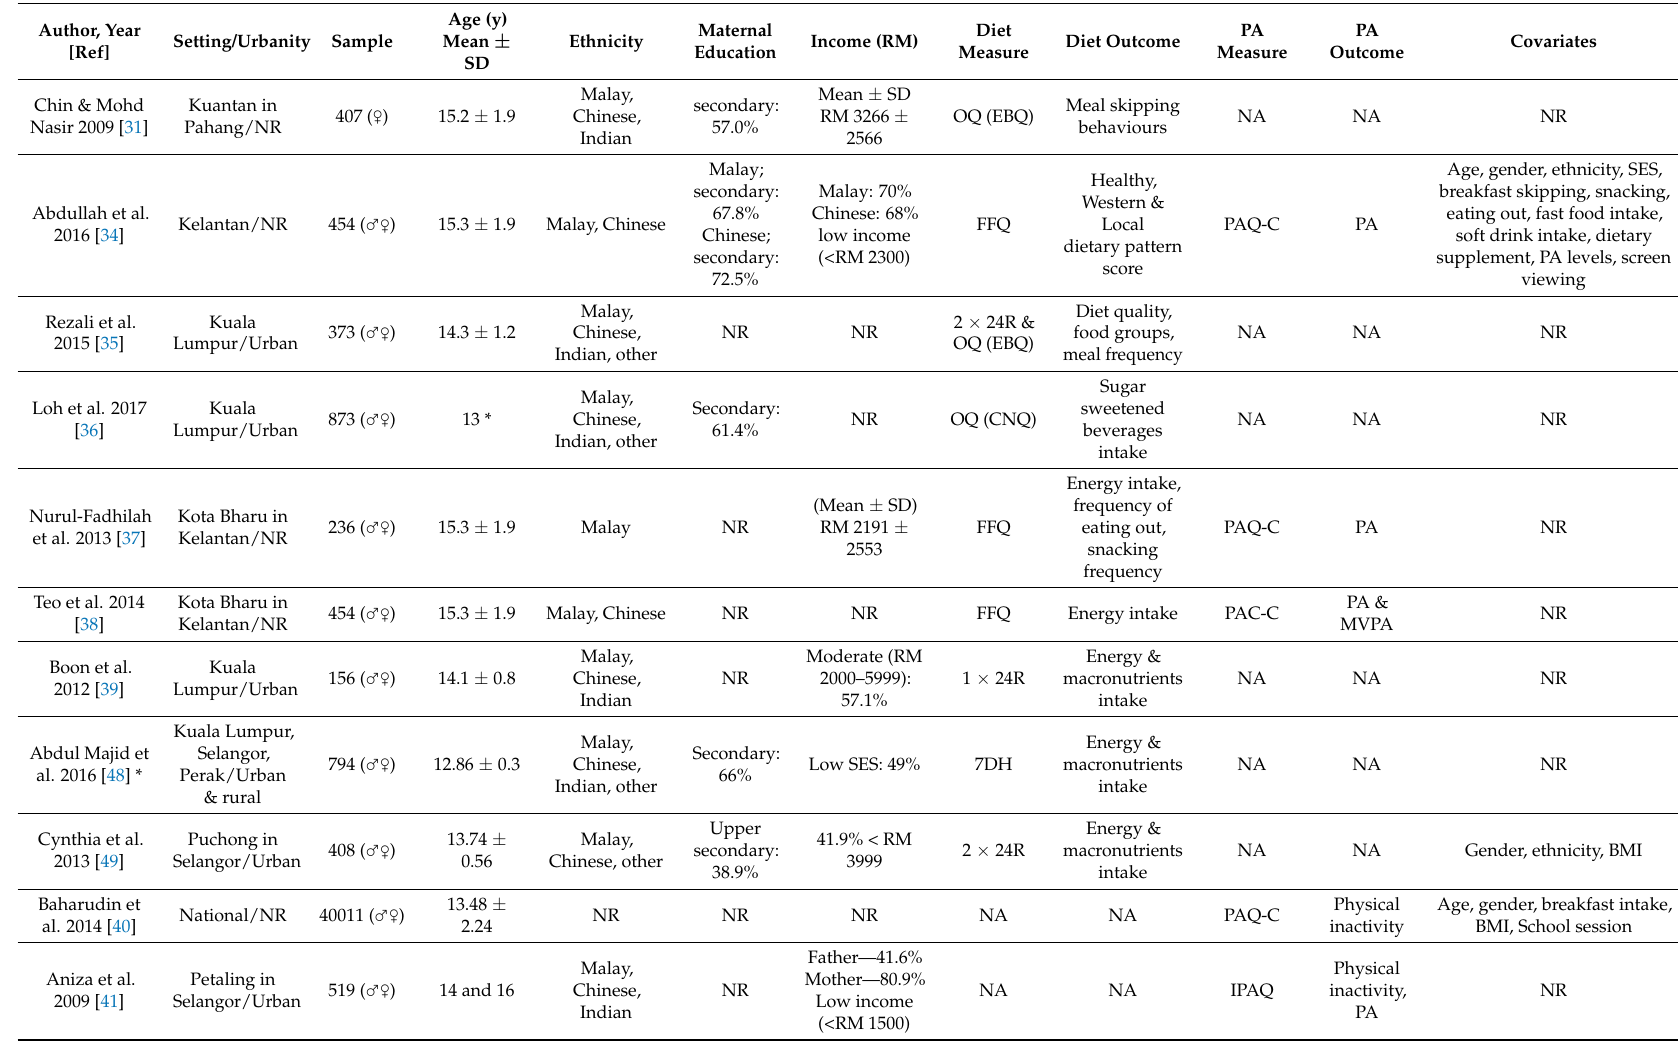
Table 1. Characteristics of the included